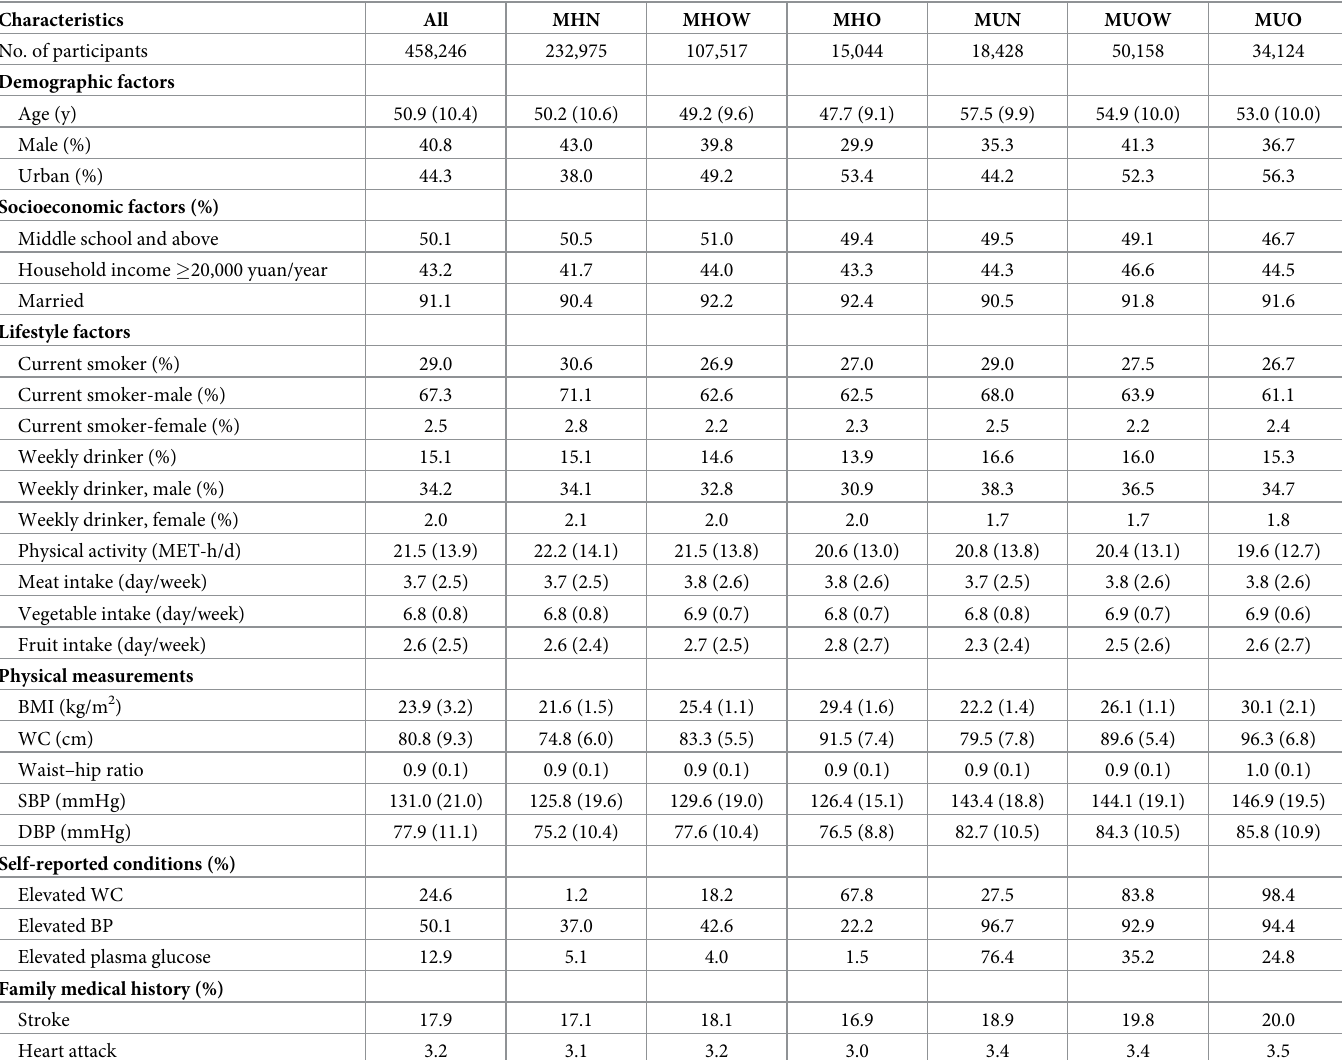
Table 1. Baseline characteristics of the study